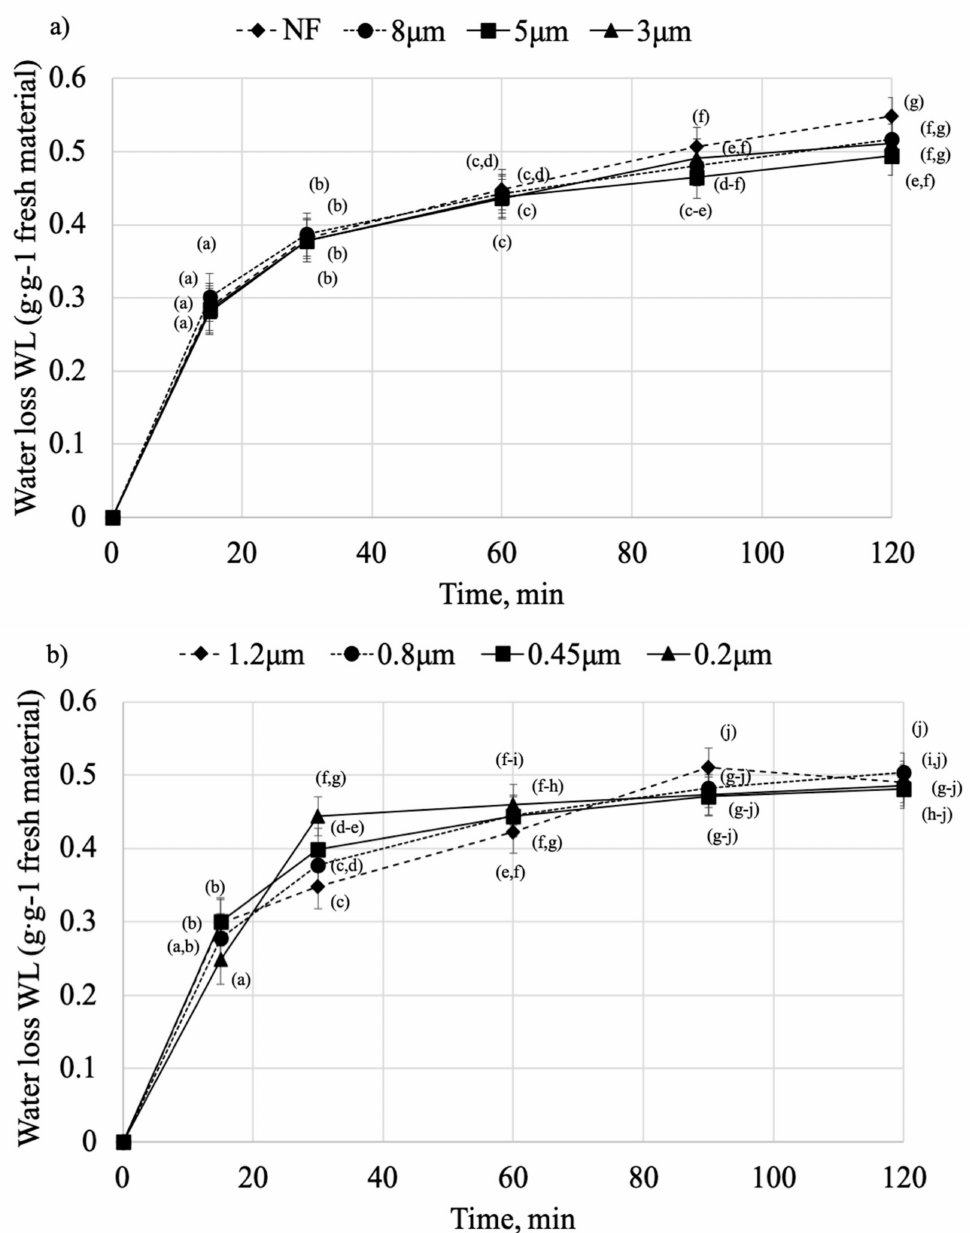
Figure 3. Water loss (WL) of the pumpkin cylinders dehydrated in different osmotic solutions: ( a ) OS > 3 µ m, ( b ) OS < 3 µ m. Mean values followed by the same letter were not significantly di ff erent ( p < 0.05) according to the HSD Tukey’s least significance di ff erence